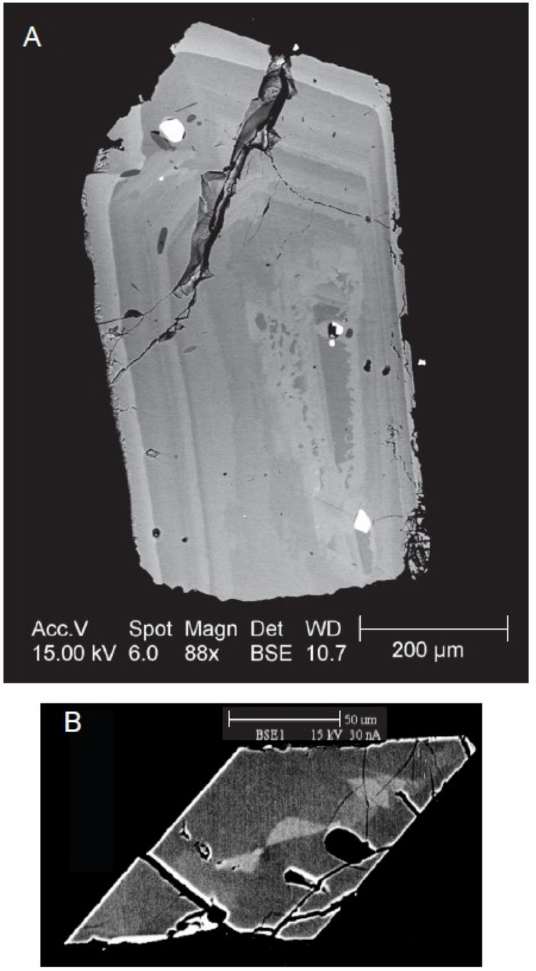
Figure 7. BSE images of titanite grains from pyroclastic rocks. ( A ) Broken euhedral grain from the Cenozoic Racer Canyon Tuff, western Utah with a patchy interior zone overgrown by oscillatory zones. ( B ) Euhedral grain from the Cenozoic tuff of Toiyabe, central Nevada with prominent sector